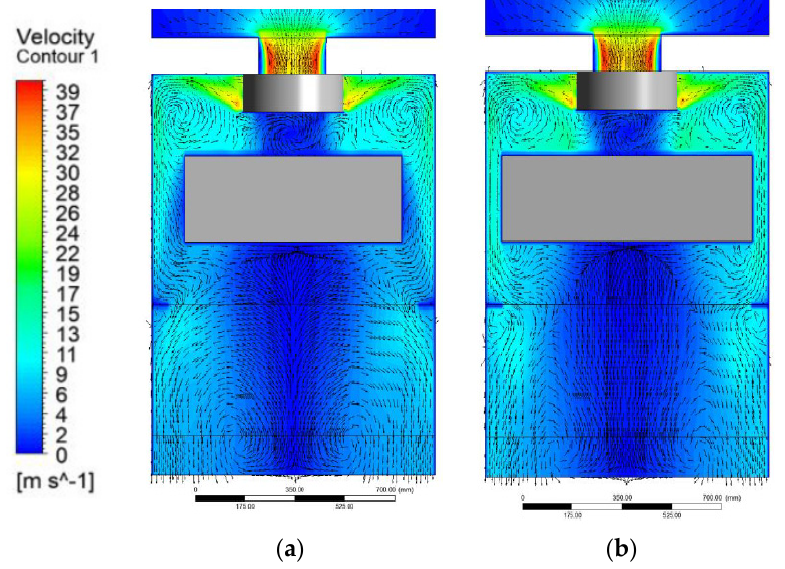
Figure 8. Velocity contour inside the AHU with ( a ) FCU1 and ( b ) FCU 2.